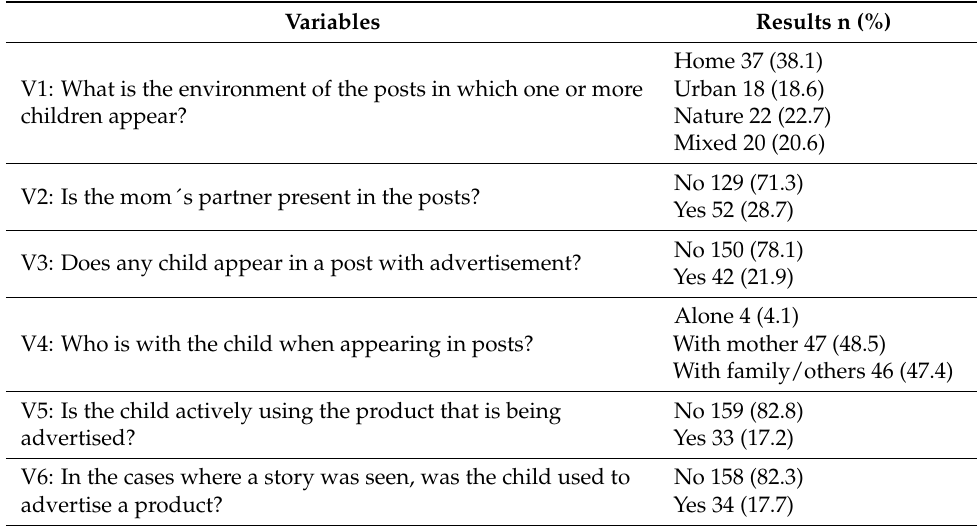
Table 1. Summary of the variables used to describe the presence and situations in which children appear in the Instamom posts.